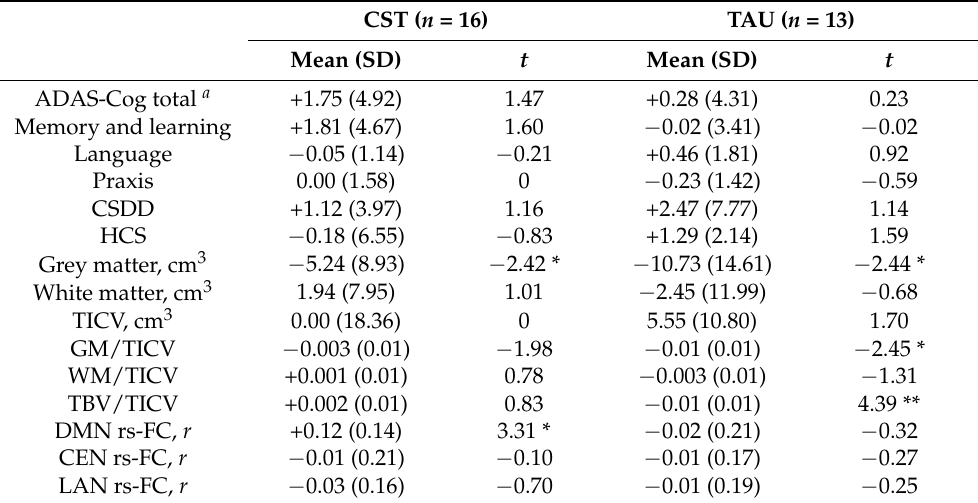
Table 2. Within-subject changes in neuropsychological and MRI measurements after CST and